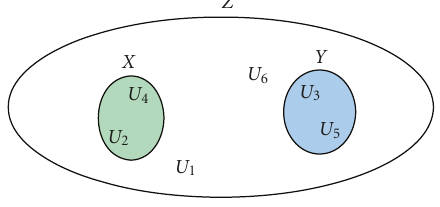
Figure 1: Graphical representation of hub concept.